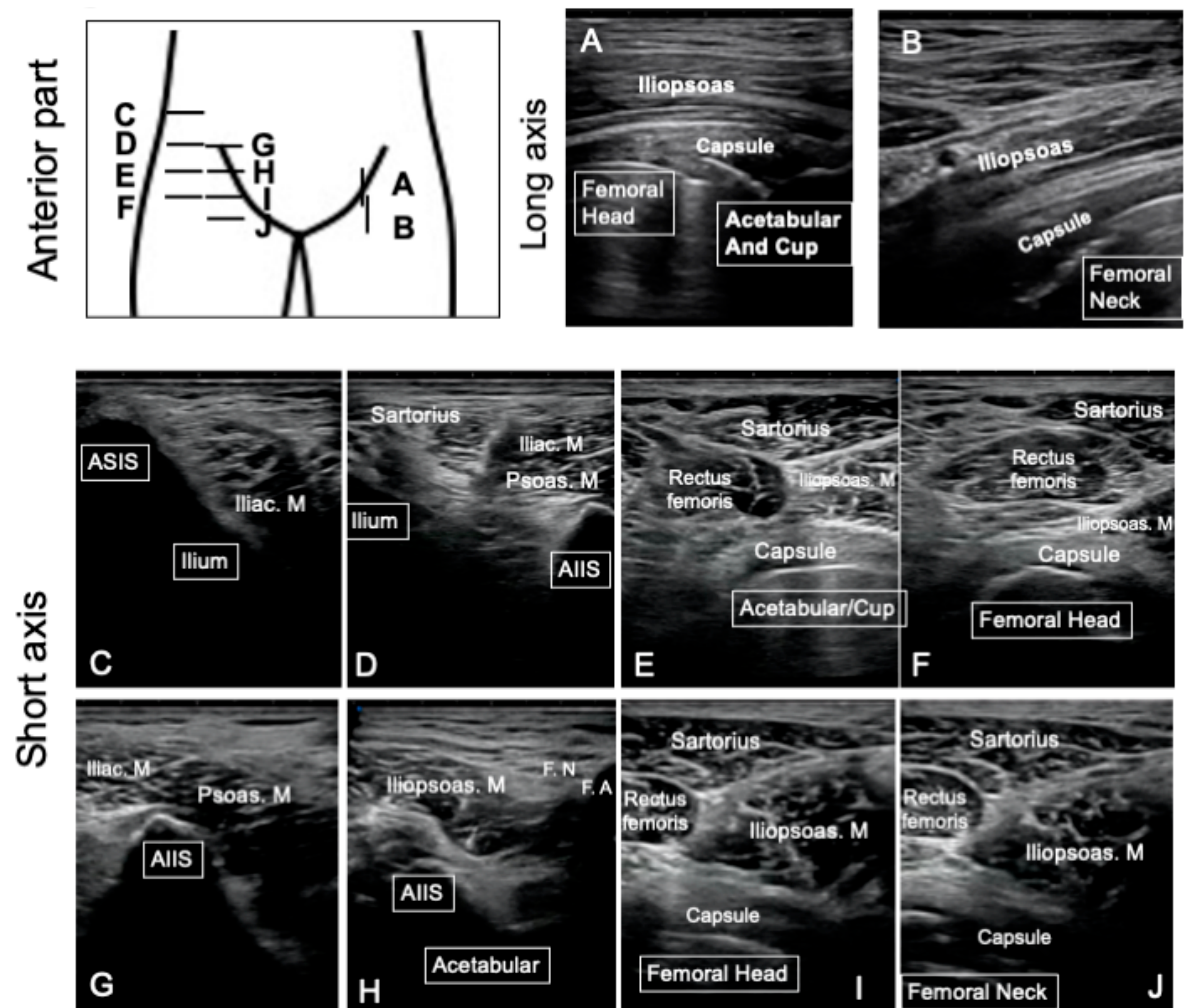
Figure 1. Representative sonography images of the anterior part in hip resurfacing patients. Periprosthetic hip soft tissues of the anterior part were assessed by longitudinal ( A , B ) and short axial ( C – J ) images. In the longitudinal images, the iliopsoas and capsule in front of the acetabular, cup, resurfacing head, and femoral neck were observed ( A , B ). In the short axial images ( C – J ), the iliac and psoas muscle, sartorius, rectus femoris, and capsule were observed using the anterior superior iliac supine (ASIS) ( C ), anterior inferior iliac supine (AIIS) ( D , G , H ), femoral nerve (F.N.), and femoral artery (F.A.) ( H ) as bony landmarks.